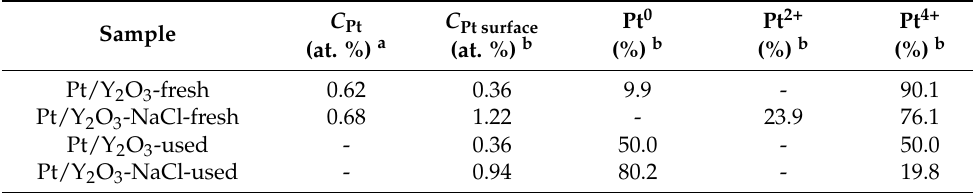
Table 4. XPS fitting results for fresh and used Pt/Y 2 O 3 -NaCl and Pt/Y 2 O 3 catalysts.